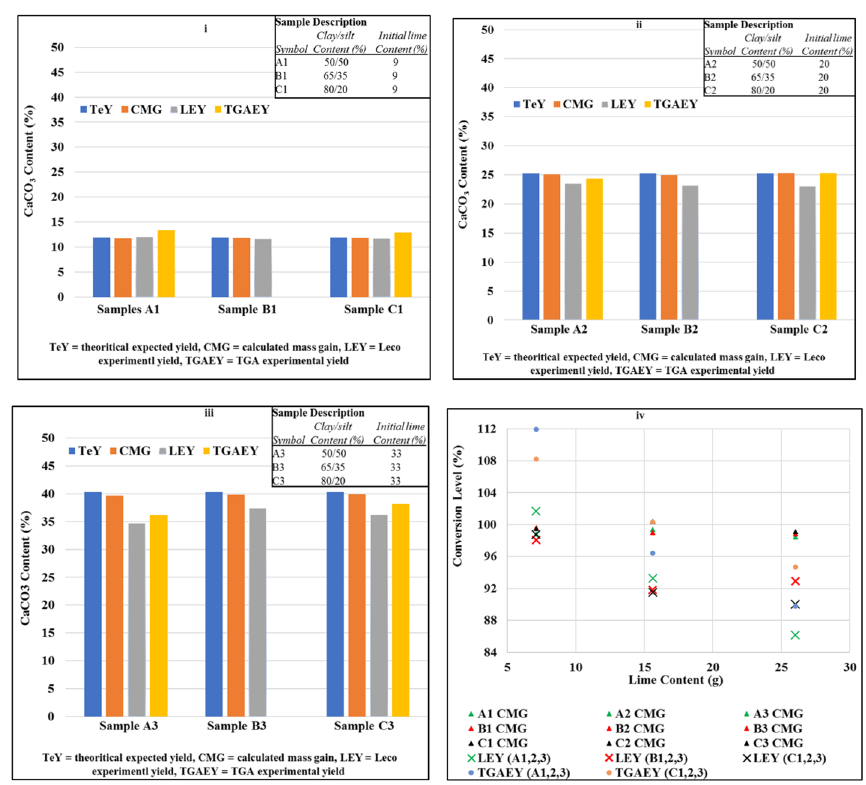
Fig. 3 Carbonation success level as related to the theoretical expected CaCO 3 yield (i) moderately calcareous (ii) strongly calcareous (iii) very strongly calcareous samples (iv) percent lime-to-calcium carbonate conversion levels